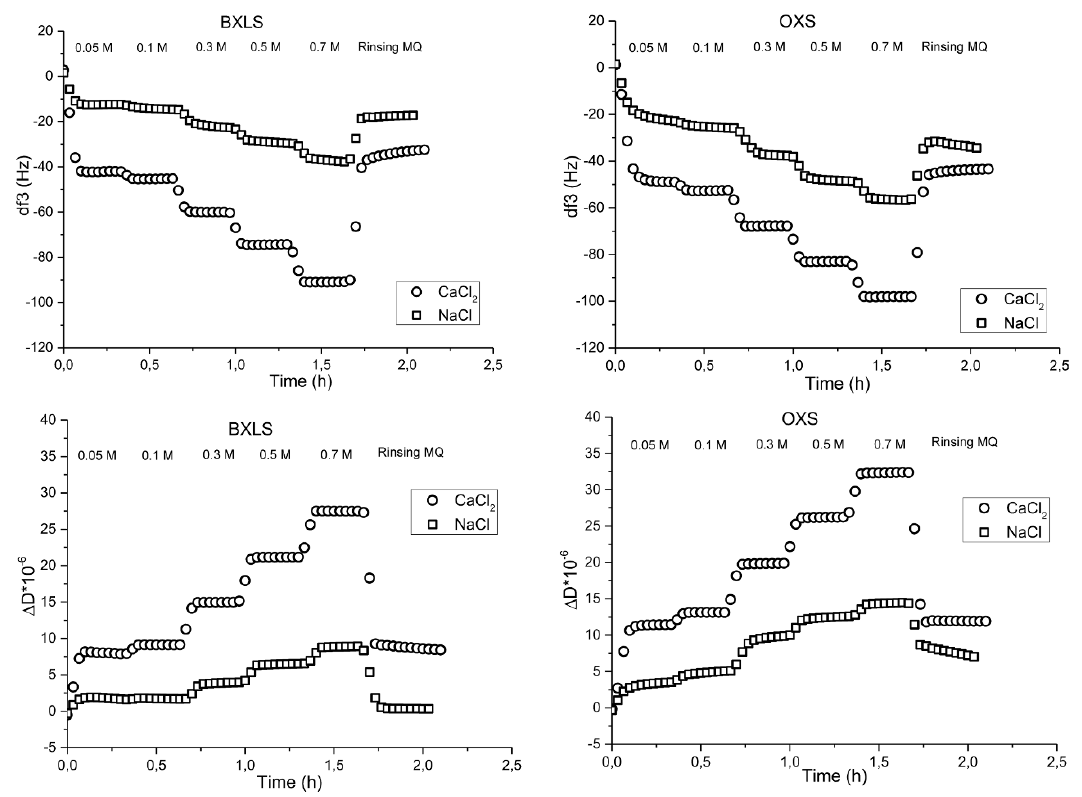
Figure 4. Frequency (third overtone) ( above ) and dissipation ( below ) changes as a function of time during the adsorption of sulfated glucuronoxylan (BXLS) and arabinoxylan (OXS) onto PET model films in the presence of electrolytes (NaCl and CaCl 2 ).